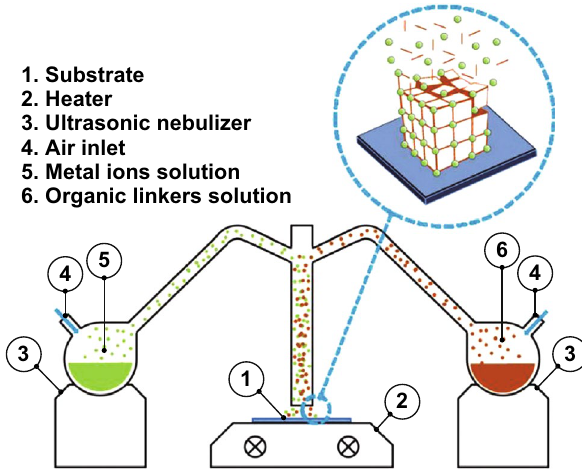
Fig. 32 Scheme of the ultrasonic spray deposition system. Reprinted with permission from Ref. [91] Copyright 2019,